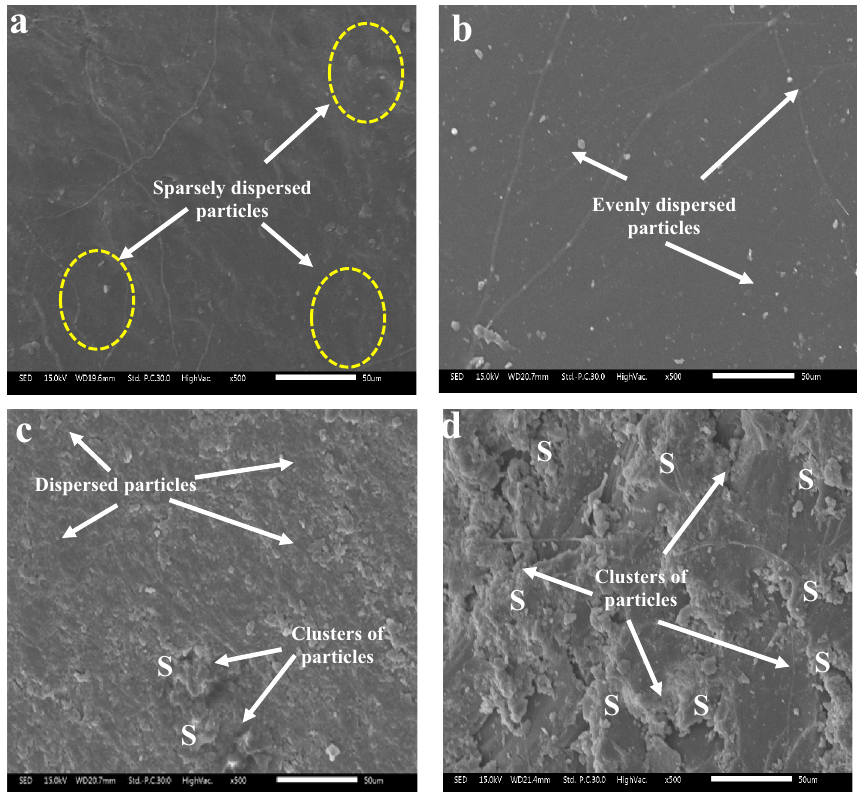
Figure 8. SEM images of selected specimen prepared with coconut shell ash of particle size 20 µm and proportions of ( a ) 10 wt.% ( b ) 20 wt.% ( c ) 30 wt.% and ( d ) 40